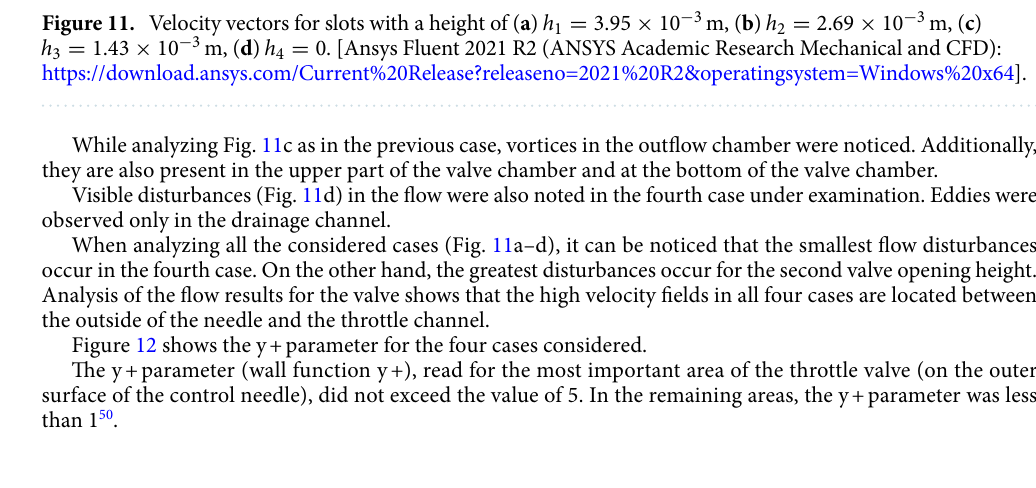
0 . [Ansys Fluent 2021 R2 (ANSYS Academic Research Mechanical and 4 =